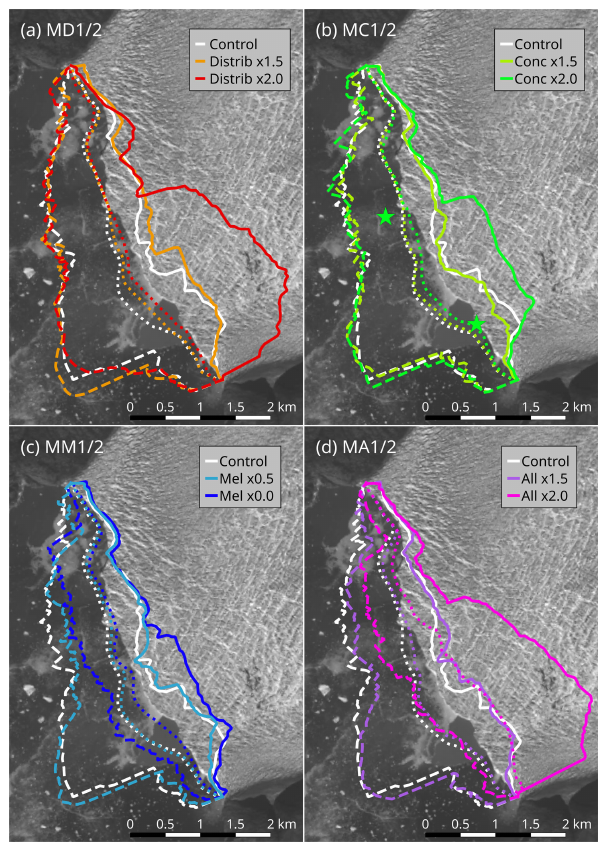
Figure 3. Maximum (dashed), mean (dotted) and minimum (solid) terminus positions for step changes in (a) distributed melt rate (MD1, 2), (b) concentrated melt rate (MC1, 2), (c) mélange thick- ness (MM1, 2) and (d) all of the above (MA1, 2). Green stars in (b) show the position of the two concentrated plumes. White lines indi- cate the control simulation. Background image: acquired by Land- sat 8 8 July